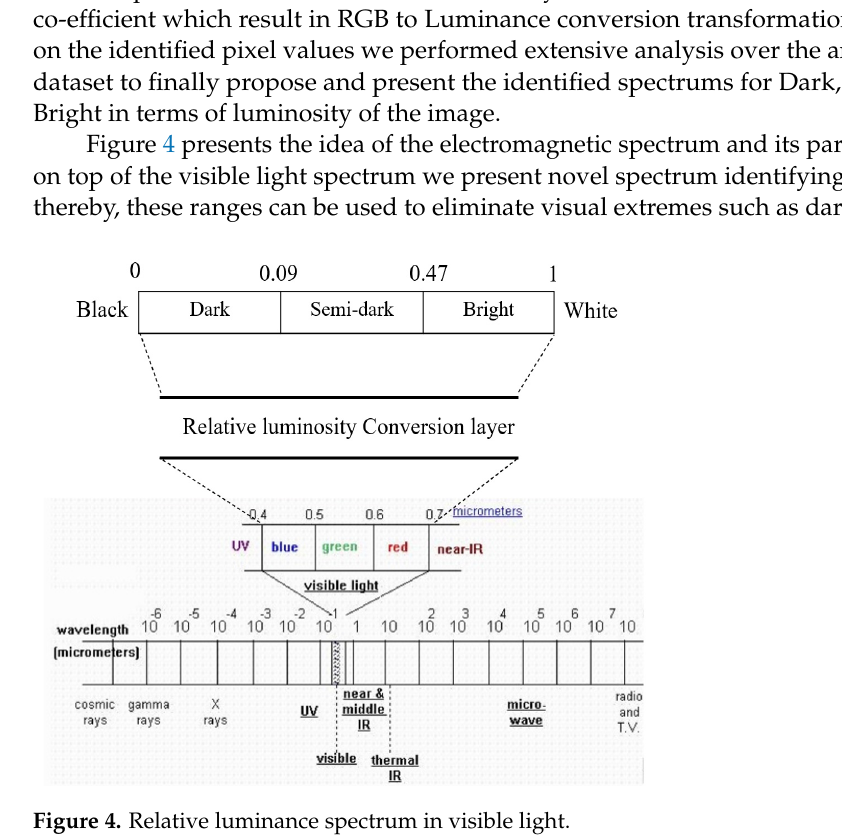
Proposed Algorithm 1: Relative Perceived Luminance Classification